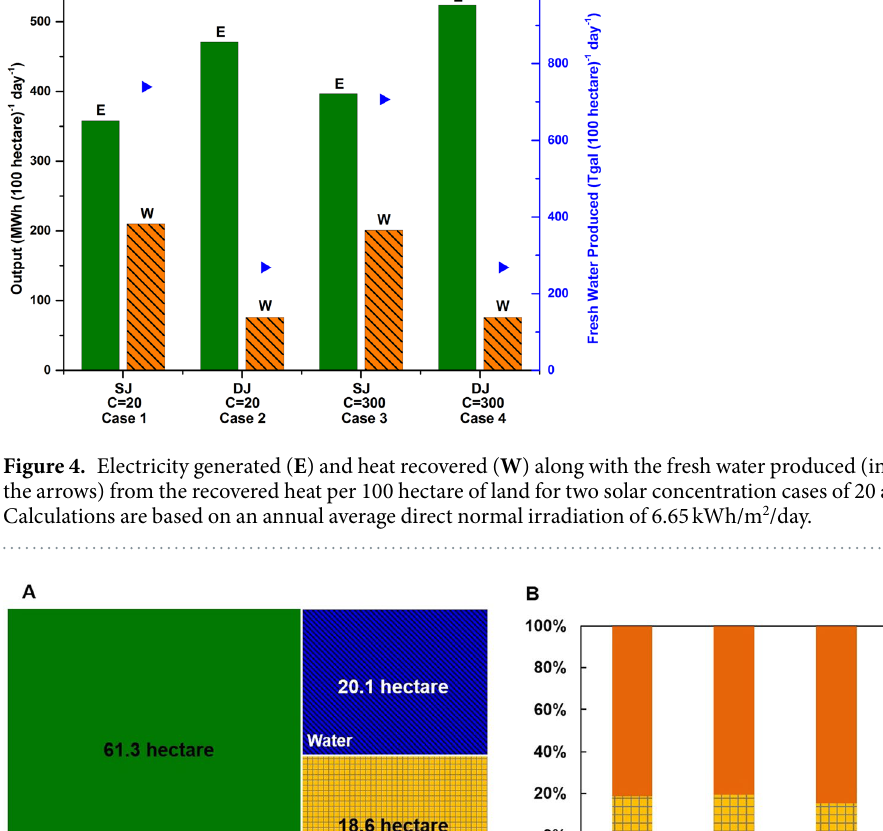
Fig. 2C. For solar concentration of 20, the daily availability for electricity is estimated to be 510 MWh with SJ solar cells and 631 MWh for DJ solar cells. For higher solar concentration of 300, the estimated electricity generation using SJ cells is 551 MWh, and 684 MWh for DJ cells (see Table S8). The benefit of SUFEWS for food production is estimated for a 100 hectare of land area split and used for ded- icated purposes of electricity generation and water production. To have the same electricity and water output of case 1, 61.3 hectare land area should be dedicated to electricity generation and 20.1 hectare for water production, which leaves 18.6 hectare land for food production (Fig. 5A). Without SUFEWS, food production is reduced by 80.7% to 84.9% relative to the full potential of the land as shown in Fig. 5B. Furthermore, due to the local availability of electricity and heat, water in SUFEWS farms will be more amenable to local water management in the form of improved irrigation (including drip irrigation) and collection/purification of runoff water from the farmland. Enough energy is available to purify water for local needs. This will have two benefits. First, irrigation as compared to rain-fed irrigation alone, increases crop yield and year-to-year predictability 2 . Given that ~25% of the worldwide farmland that is irrigated produces 33% of the world’s crops, we estimate that irrigation increases yield by about 48% 31 . The global implementation of SUFEWS across all current farmlands could deliver 32% more agricultural products, solely from the irrigation improvement. Second, runoff water from farmland will be col- lected and purified to decrease the need for clean water, as it can be recycled back to the field or lake, rivers, and other aquifers and, therefore, reduces the water footprint (Fig. 3). Also, nitrogen and phosphorous rich streams from the purification of the runoff water may be recycled, leading to reduction in fertilizer demand and avoiding algal blooms in aquifers receiving runoff water 2 . Alternatively, nutrient rich water streams can be sent for further downstream processing. Furthermore, for farmlands located near coastal areas, fresh water can be produced by desalination using energy from a given farm land area using SUFEWS; any surplus supply can be sent to adjoining urban areas.